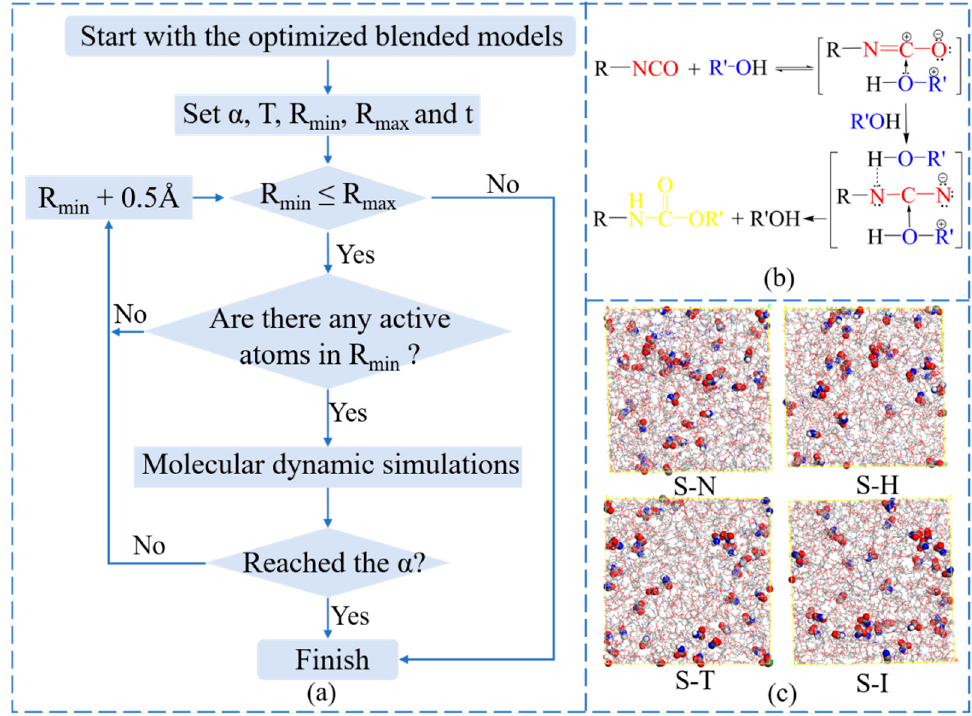
Figure 2. ( a ) Flow chart of the crosslinking reaction algorithm; ( b ) The curing reaction mechanism of IPN binders; ( c ) the crosslinking basic models of IPN binders.